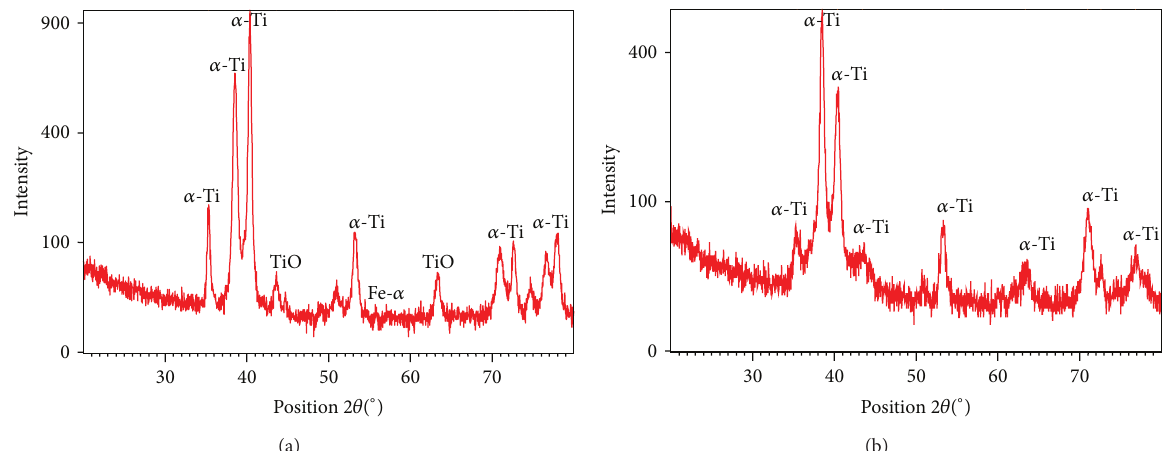
Figure 6: XRD spectra of debris produced at sliding speed of 600rpm and applied normal load of (a) 50N and (b) 90N.